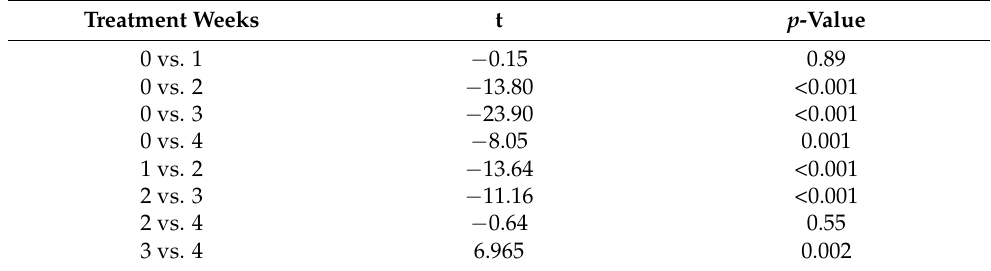
Table 4. Statistical analysis results of the comparisons between weeks of